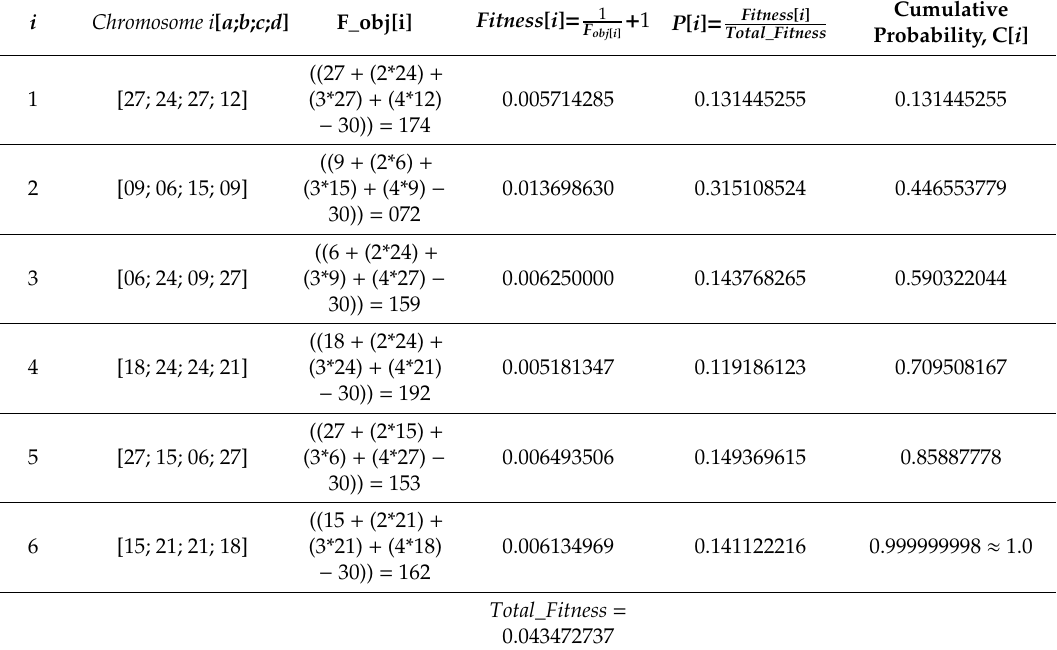
Table 4. Determination of fitness function and probability for the first